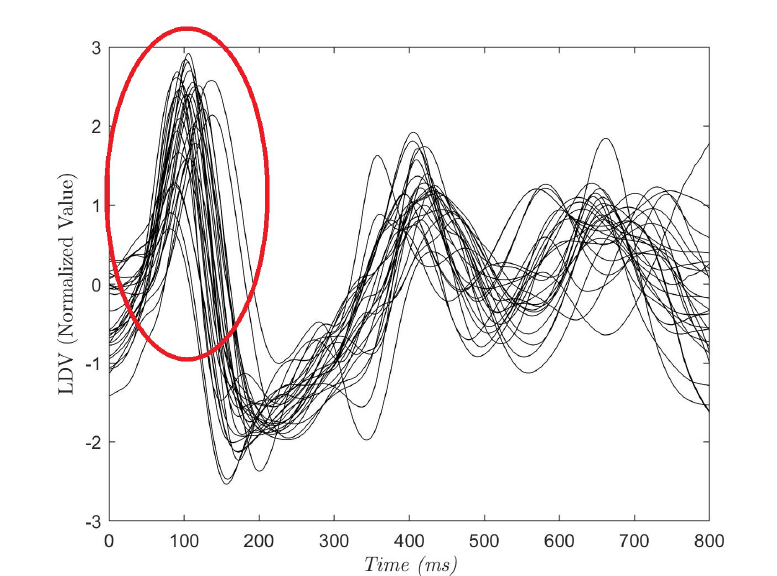
Figure 4. Each curve refers to one subject and is the average of a portion of the LDV signal. The portion starts from the R peak in the electrocardiograph (ECG) and last 800 ms. The red circle shows the LDV pulse wave peak that can be found at 102 ± 15 ms after the